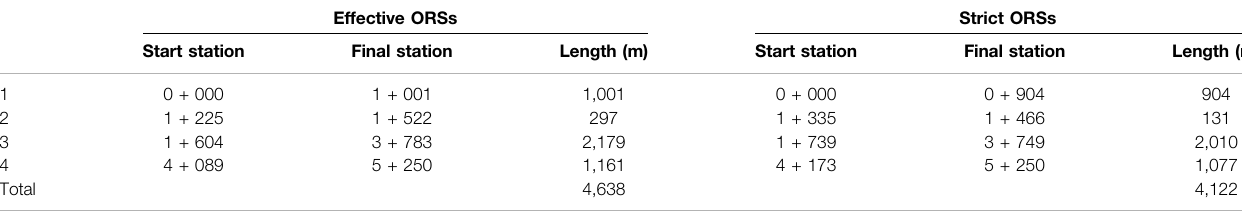
TABLE 1 | Operational Road Sections traveling at speed limit (90